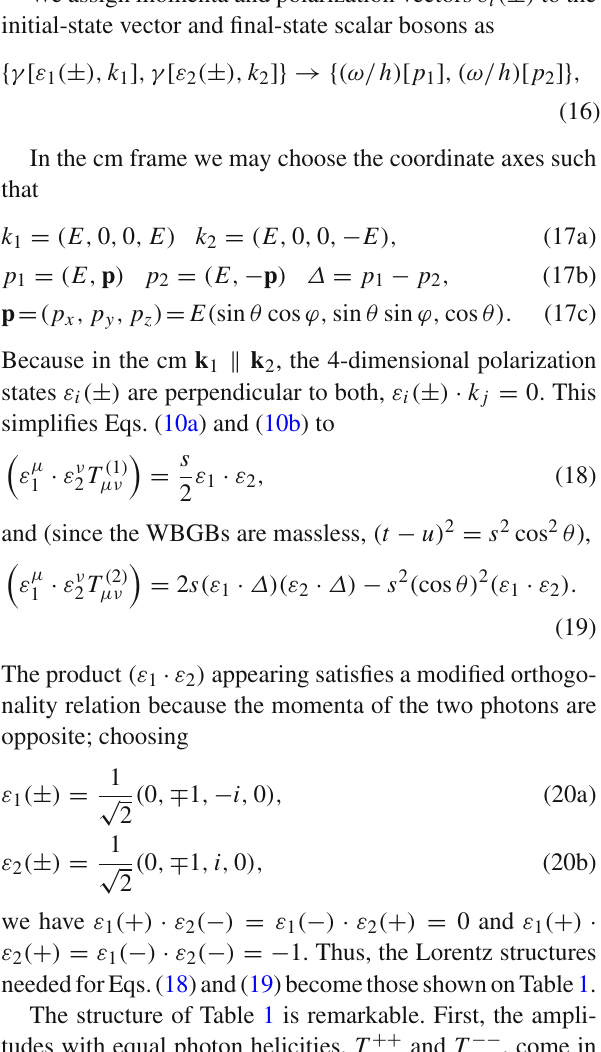
Fig. 1 A sensible counting for ωω → γγ , in the energy region around O ( 0 . 5 TeV ) of interest for the LHC, is to take α small quantities with α EM (of smaller size) only to first order. The resulting counting ( green dots ) is compared with that for the purely Goldstone boson processes ωω → ωω ( red dots )